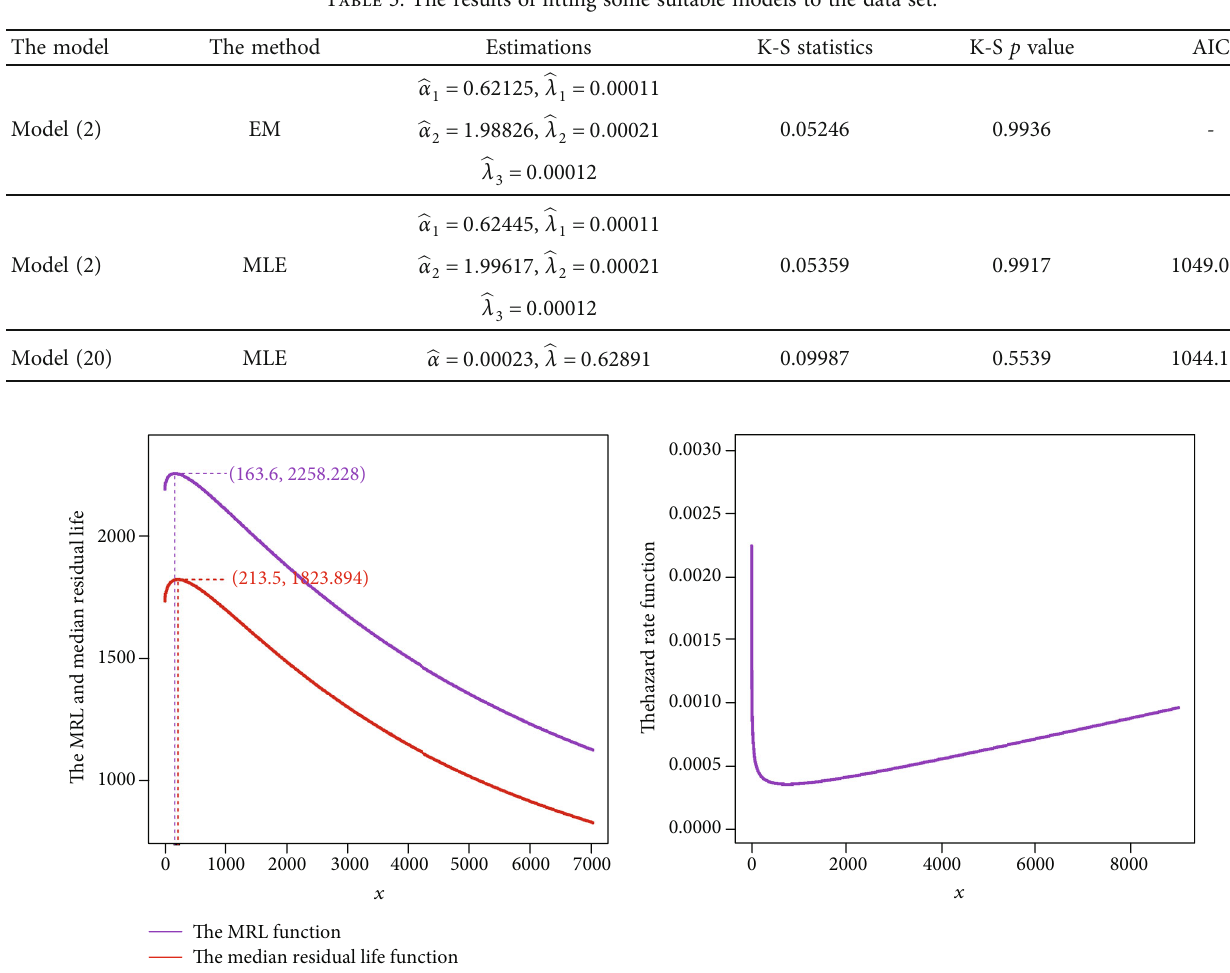
Figure 3: (a) The mean residual life and the median residual life of the fi tted model. (b) The hazard rate function of this fi tted model.